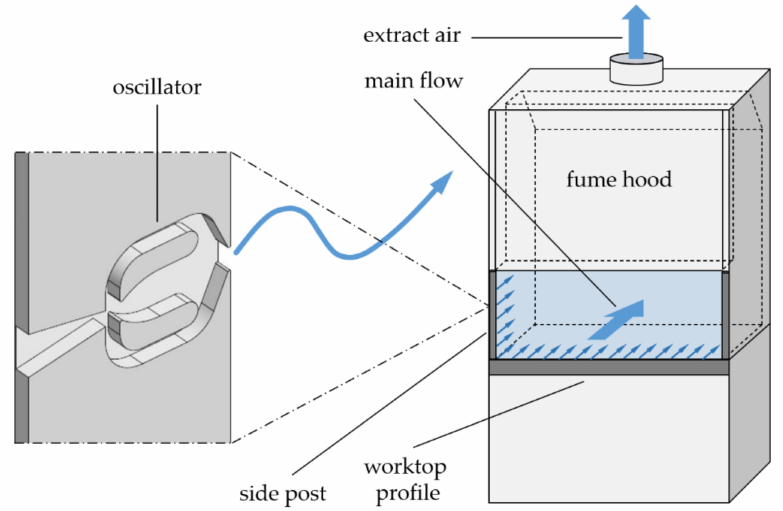
Figure 10. Orientation of oscillators integrated in the frame profiles of the front opening— schematic